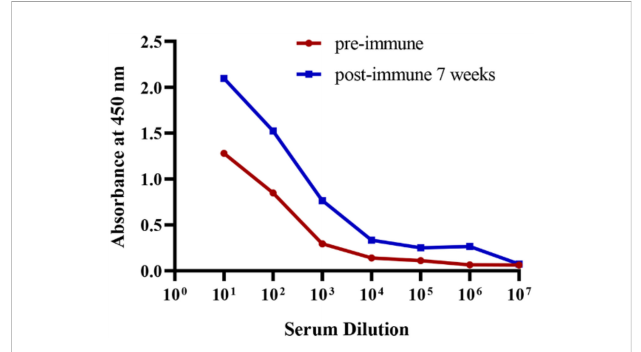
FIGURE 1 ELISA analysis of the BFT1 speci fi c antibody titers from pre-immune and post-immune (7 weeks) alpaca serum.